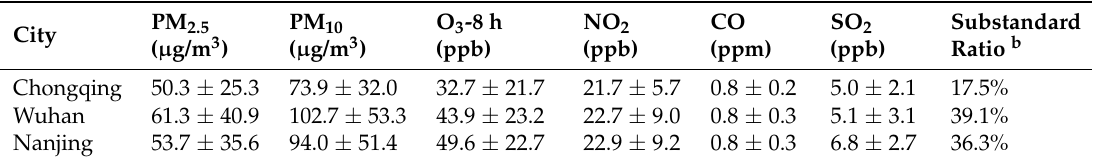
Table 2. Annual mean concentrations of six criteria pollutants in Chongqing, Wuhan, and Nanjing during 2015–2016 a